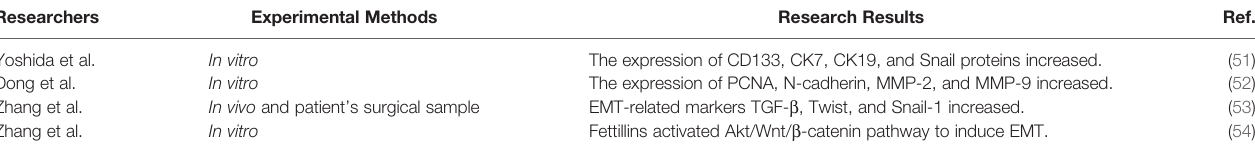
TABLE 1 | EMT in recurrence after ablation of